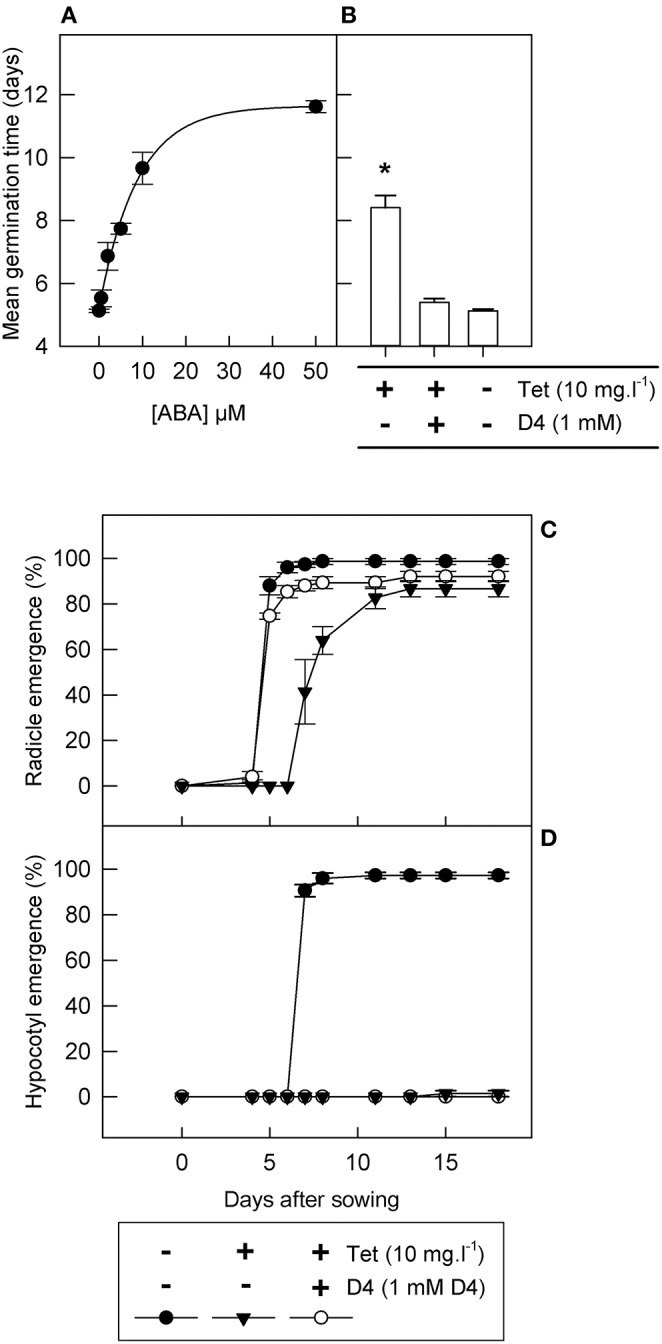
D4 reverses the effect of inducible LeNCED1 expression on radicle emergence in transgenic tobacco seed. (A) Tobacco seed were imbibed in the absence of tetracycline on filter paper wetted with 0–50 μM ABA and mean germination time was calculated; the curve was fitted using a three parameter exponential rise to maximum model (R2 = 0.95; p < 0.001). (B) Tobacco seed were sown on filter paper wetted with or without 10 mg l−1 tetracycline and 1 mM D4, as indicated; all treatments additionally contained 0.2% DMSO, required to solubilize D4; *indicates significant difference (p < 0.05) compared to 0.2% DMSO control, according to ANOVA least significant difference; in both (A,B), mean germination time is based on radicle emergence. (C,D) show a time course of radicle emergence and hypocotyl emergence, respectively, with or without 10 mg l−1 tetracycline (Tet) and 1 mM D4, as indicated. Error bars indicate standard error (n = 3); all treatments also contained 0.2% DMSO.